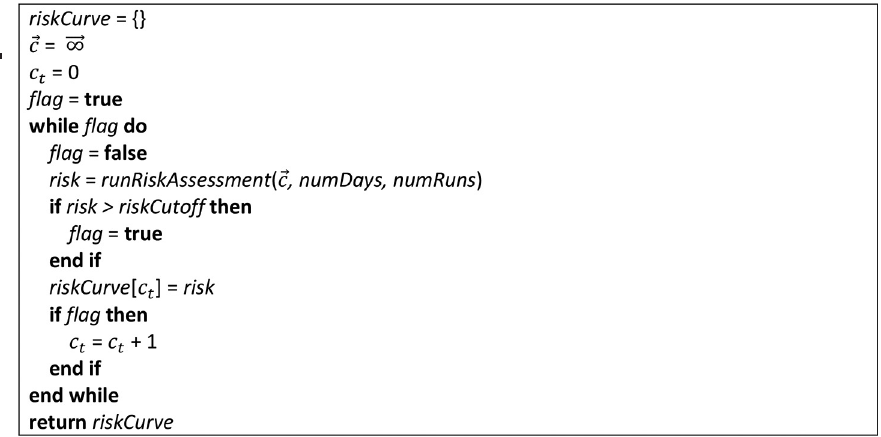
Algorithm 2 . This function computes risk versus number of trucks required to sustain supplies for a given truck type, for risk levels less than some input cutoff. Additional inputs include number of days and number of runs for the simulation performed in runRiskAssessment ( Algorithm 1